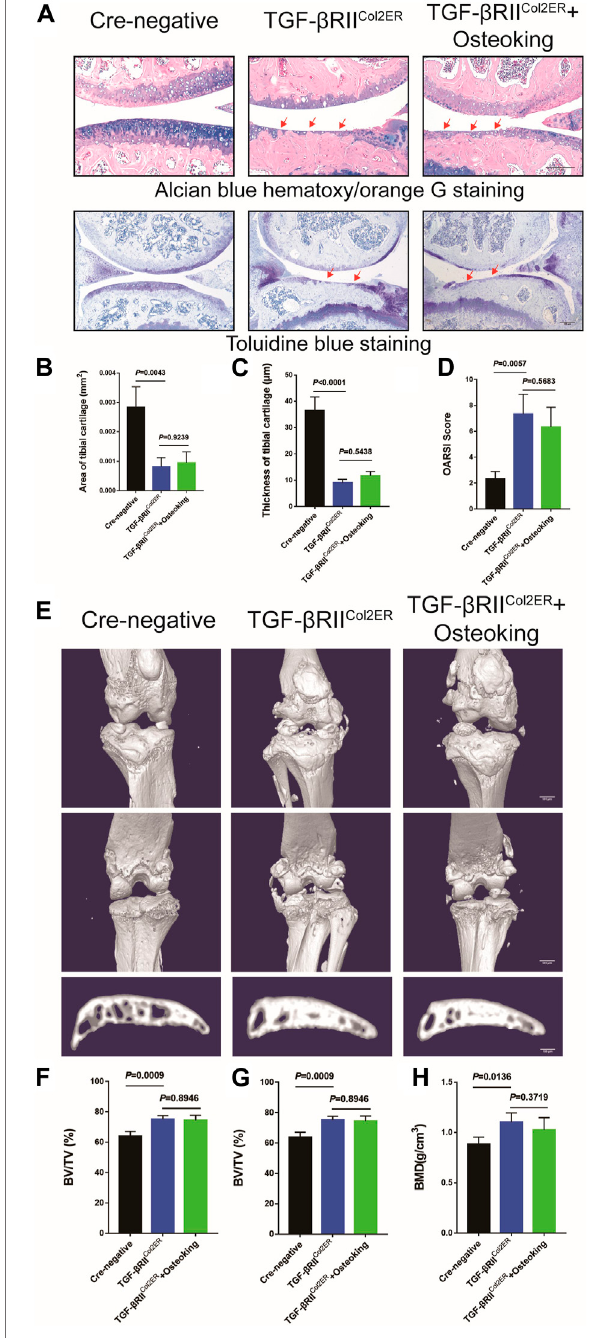
FIGURE 5 | The cartilage protection effect of Osteoking was lost in TGF β RII Col2ER mice. (A) Alcianbluehematoxylin/orangeGstainingandToluidineblue stainingofthe tightkneejoint in TGF β RII Col2ER mice. Red arrows indicate thearea of cartilageerosion.Scalebar (cid:2) 100 μ m.Morphologicalquantitativeanalysisof (B) area of tibial cartilage (mm 2 ) and (C) thickness of tibial cartilage ( μ m). (D) OARSI scoring of the sections analyzed by histomorphometry. (E) Representative 3D reconstruction of the right knee joint and subchondral bone. Quantitative analysis of thesubchondralboneofrightkneejoints (F) BV/TV(%), (G) Tb.Th(mm)and (H) BMD (g/cm 3 )werechosenastheobservationindexes.Dataarepresentedasmeans ± SD (n (cid:2) 10). The exact p value is presented in the corresponding